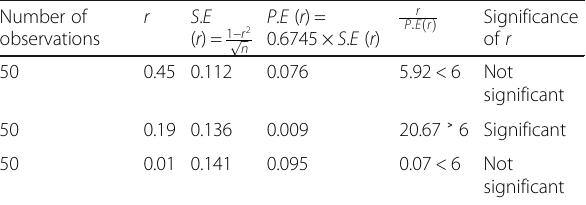
Table 8 Significance of correlation between Thumb, Index, and Ring finger per unit area for periphery position